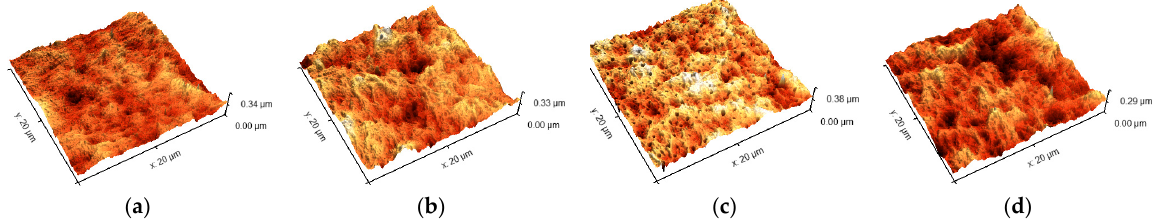
Figure 6. The visualization of the surfaces after aging for ( a ) unmodified sample; modified samples with ( b ) MFSC 1; ( c ) MFSC 4; ( d ) MFSC 5.